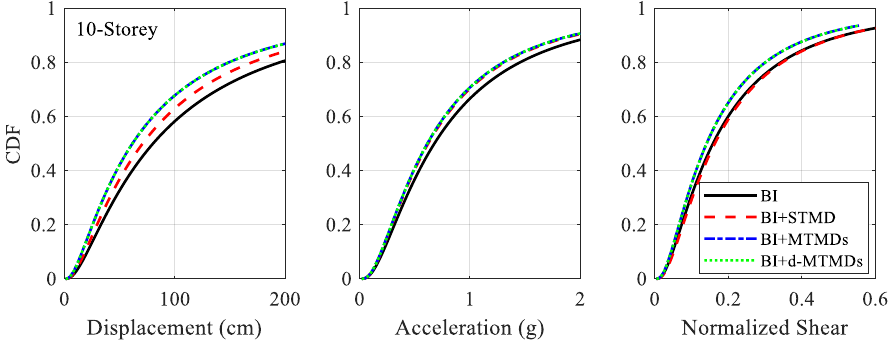
Figure 8. Cumulative probability distribution functions of maximum bearing displacement, peak top floor acceleration, and normalized shear force for 10-story